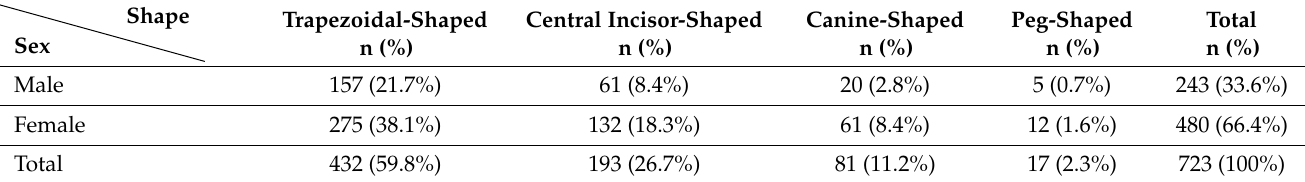
Table 1. The distribution of various crown shape of permanent maxillary lateral incisors by